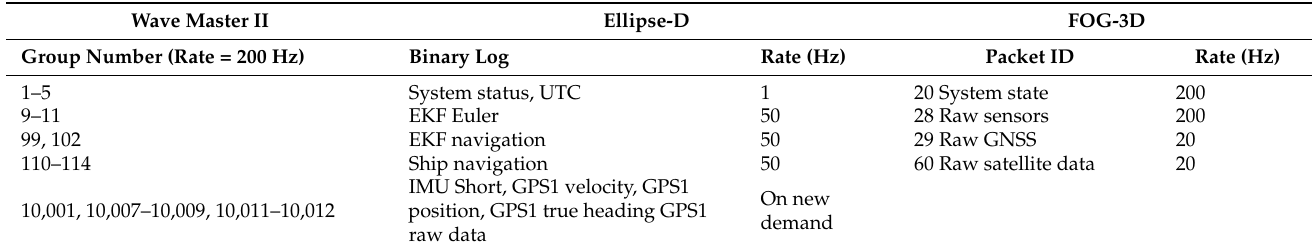
Table 2. Data packets and rates configuration for each GNSS + INS to enable post-processing.